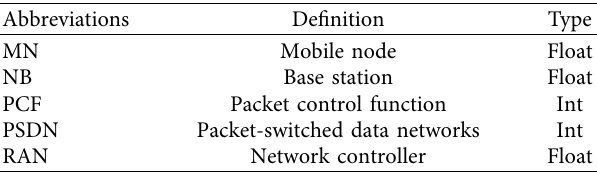
Figure 3: Hybrid intersystem structure. Table 1: Abbreviated description table.